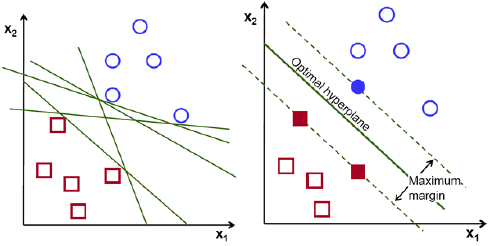
Figure 2. Principle behind Support Vector